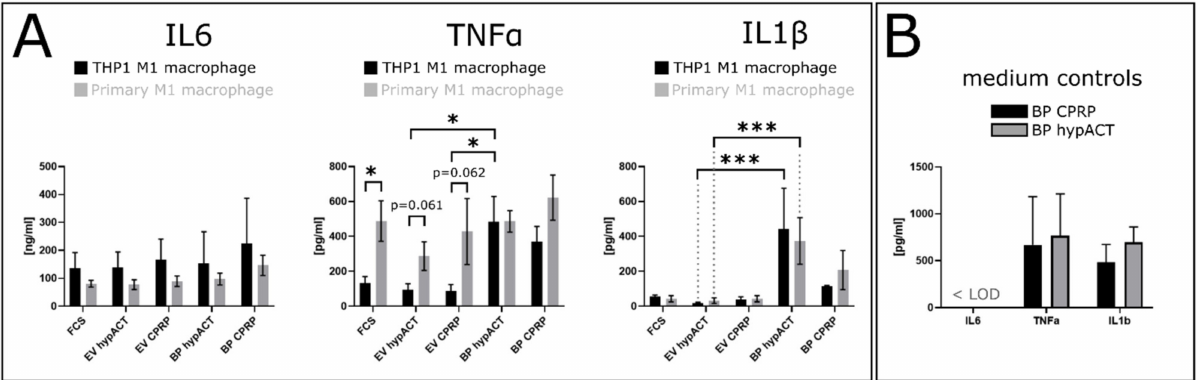
Figure 3. ( A ) Cytokine profiling involving IL-6, TNF- α , and IL-1 β levels in the presence of THP1 or primary M1 macrophages, and in different treatments, as determined via ELISA in sandwich format. ( B ) Control media were measured before starting the co-culture. Data are from at least 4 experiments ± SD. *: p < 0.05; ***: p <